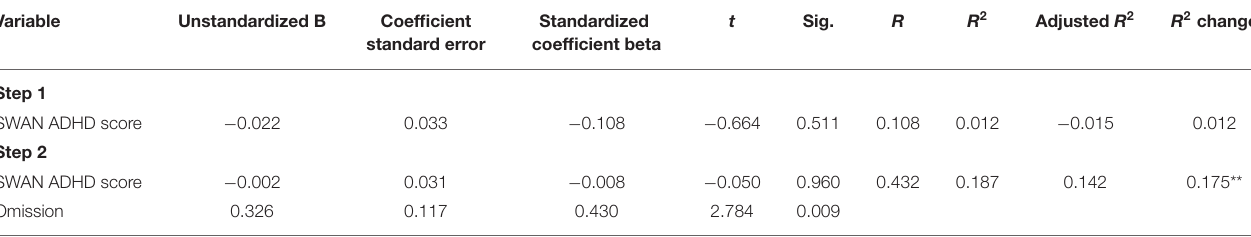
TABLE 9 | Regression model of the CCPT measures as the predictors of the CBCL social problem subscale score in the SCT group.